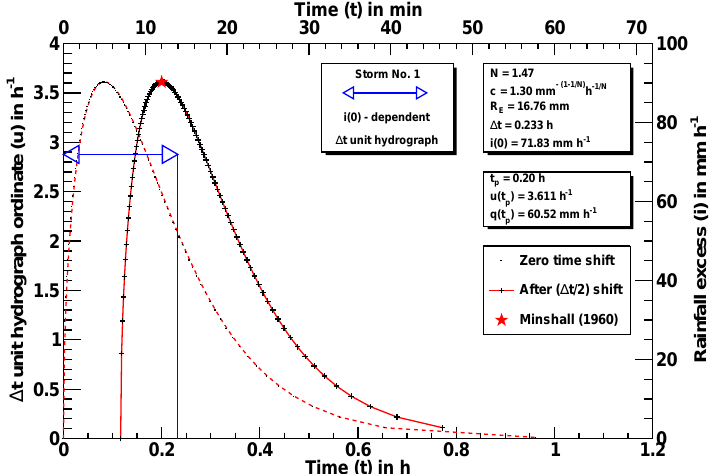
Fig. 5a. Regeneration of the 1t unit hydrograph by the direct Bakhmeteff function method of convolution for the largest storm, storm no. 1, on the Edwardsville, Illinois, watershed. For comparison, the peak characteristics reported by Minshall (1960) are shown as a red star.